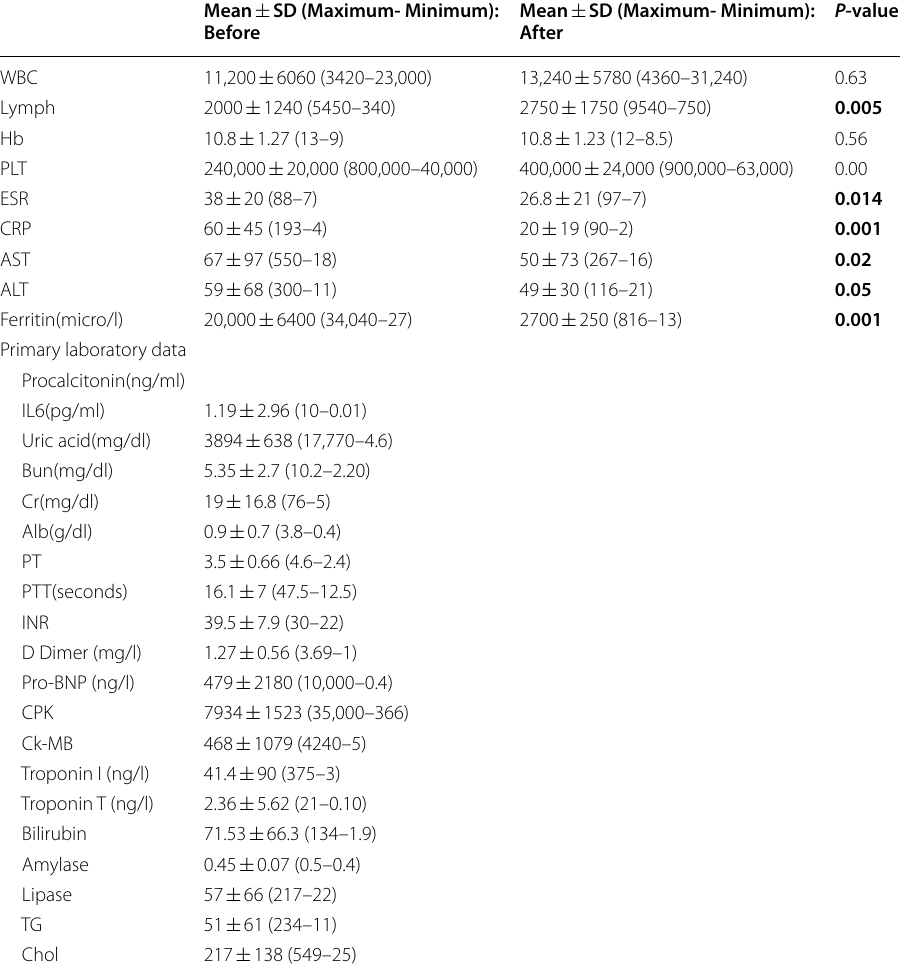
The bold values reflected the significance difference between laboratory data before and after treatment